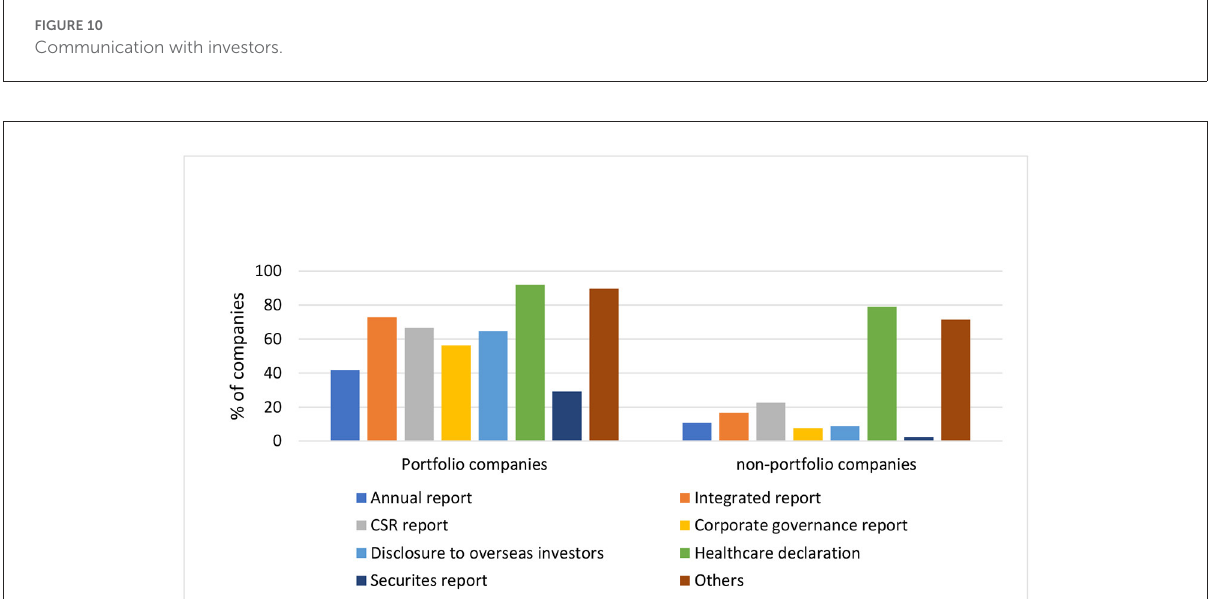
FIGURE11 Disclosure through different media by portfolio and non-portfolio companies.